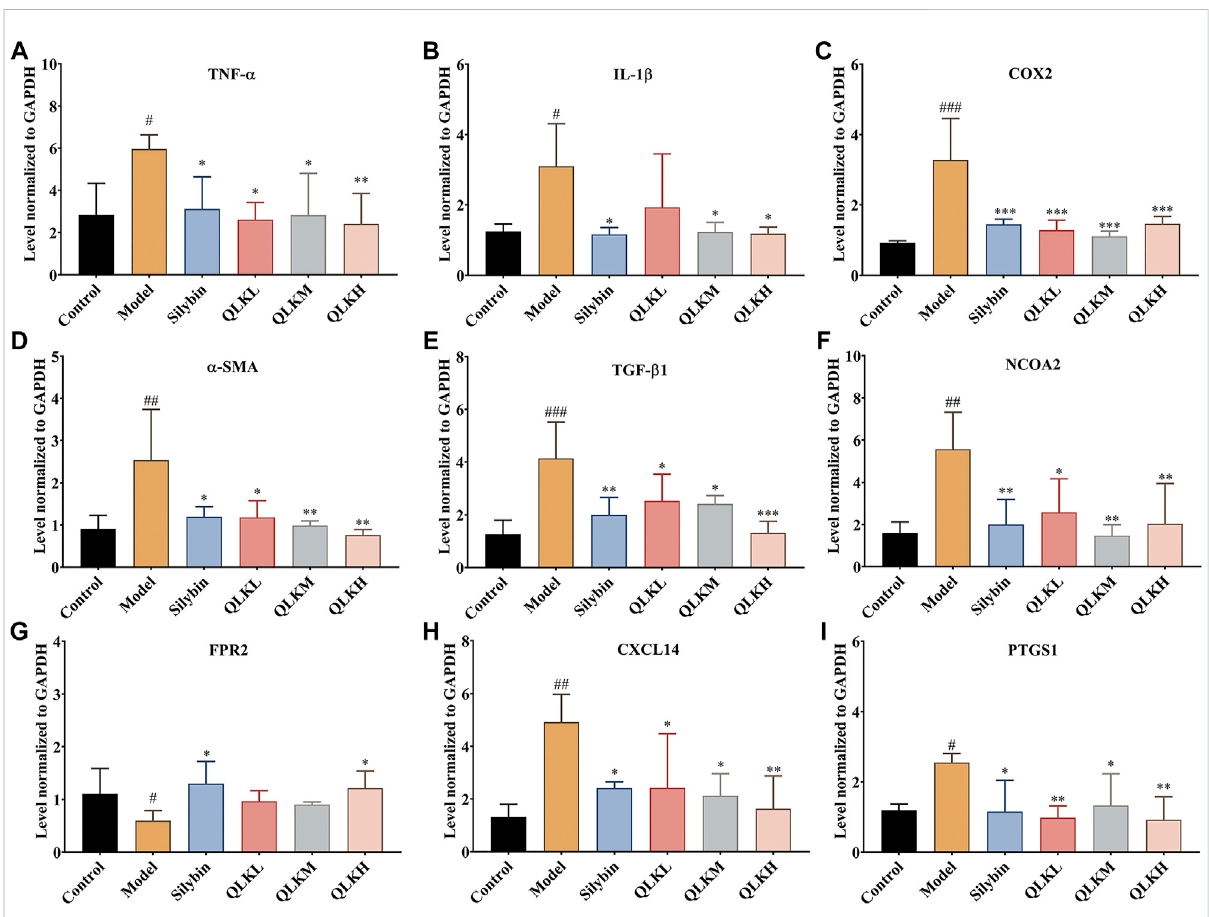
FIGURE 7 RT-PCR analysis for TNF- α , IL-1 β , COX2, α -SMA, TGF- β 1,NCOA2, FPR2, CXCL14 mRNAlevelsintheliverof model rats( n = 6). (A) TNF- α ; (B) IL- 1 β ; (C) COX2; (D) α -SMA; (E) TGF- β 1; (F) NCOA2; (G) FPR2; (H) CXCL14; (I) PTGS1; Values are presented as mean ± SD for three biological replicates per group. * p < 0.05, ** p < 0.01, *** p < 0.005 vs. model, # p < 0.05, vs. control, ## p < 0.01 vs. control, ### p < 0.005 vs.